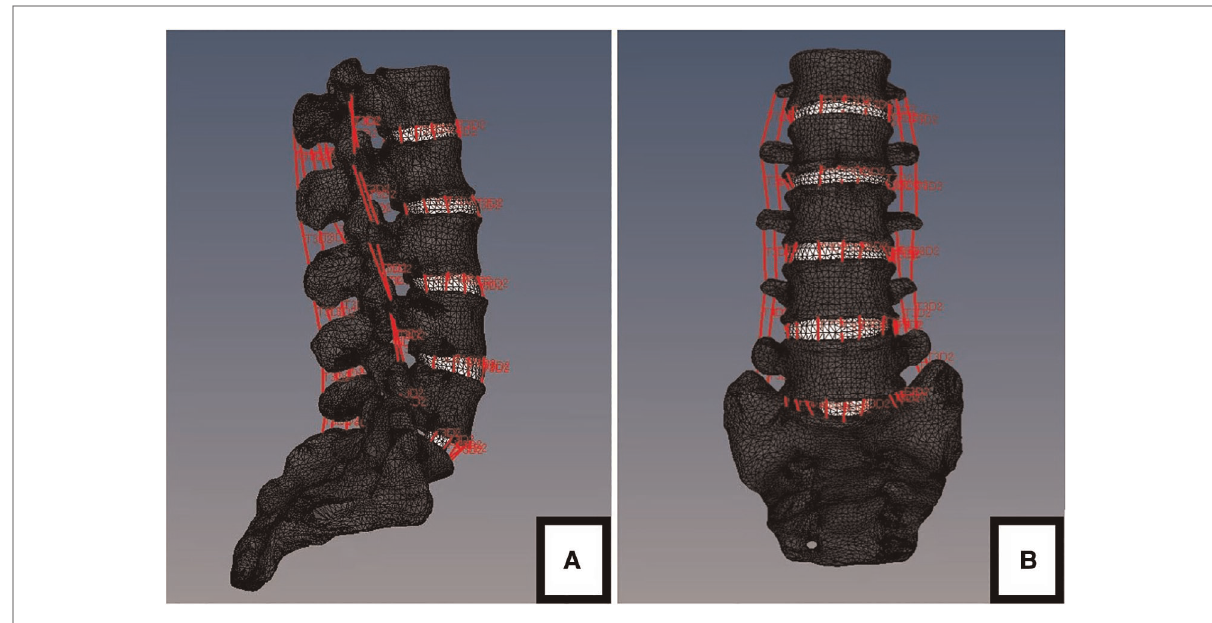
FIGURE 4 The fi nite element model of stable lumbar (L1-S1). ( A ) lateral view. ( B ) anteroposterior